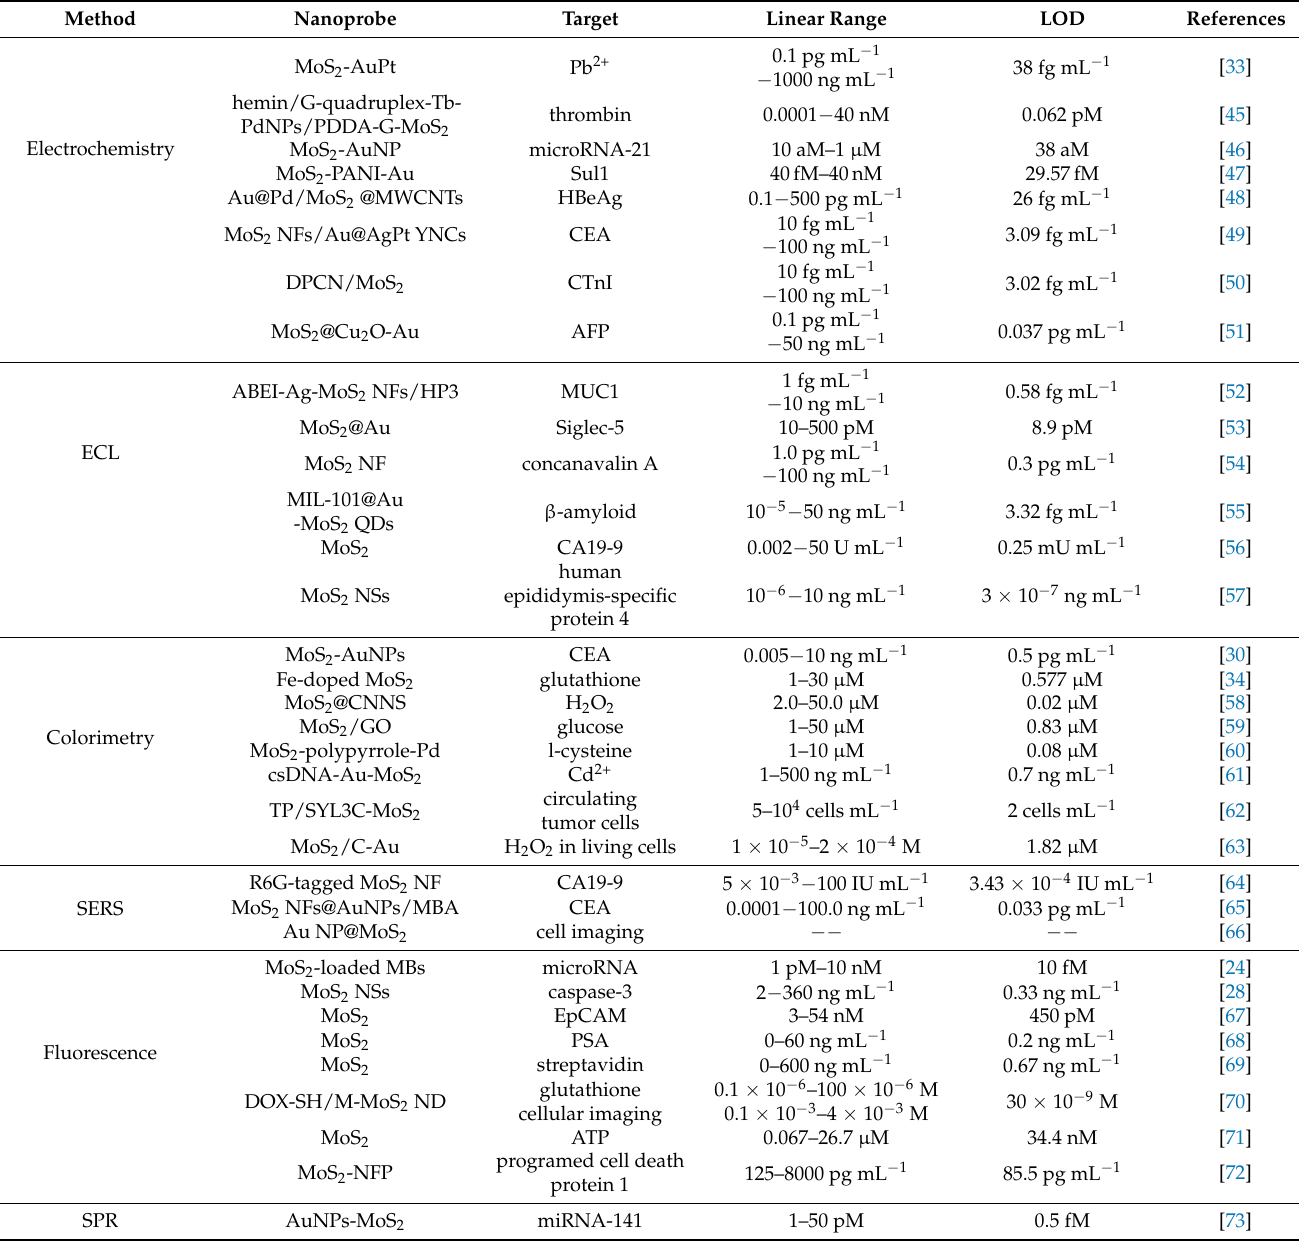
Table 3. MoS 2 -based nanoprobes for sensing